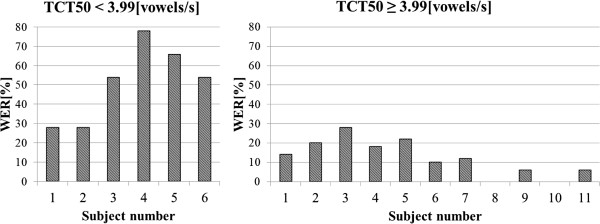
Average WER achieved by the elderly listeners for input speech with ROS equal to ROSmean3.